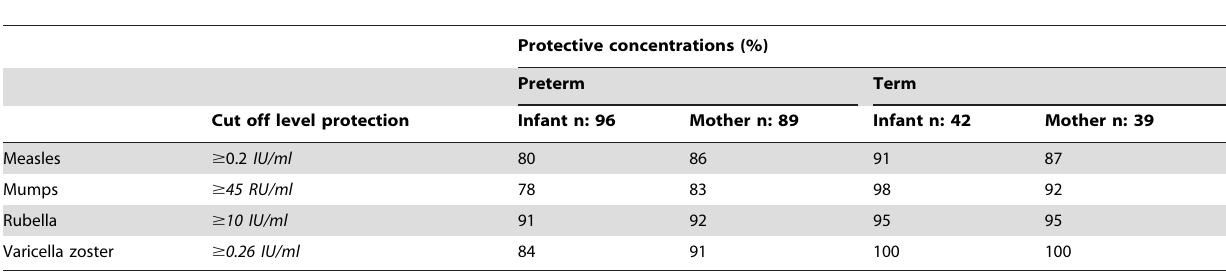
Table 2. Percentage of protected preterm and term infants and their mothers at birth to measles, mumps, rubella, varicella zoster .